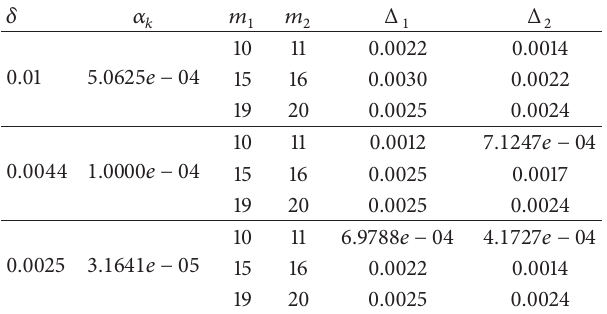
Table 1: Mesh size and corresponding